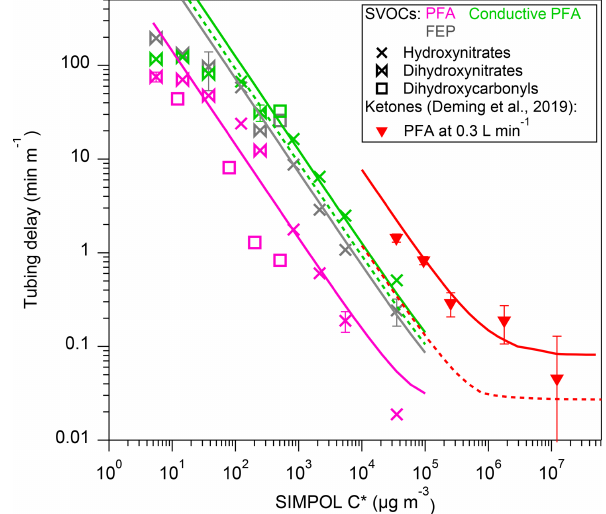
Figure 2. Measured instrument delay times as a function of SIM- POL C ∗ for five instruments. The q-PTRMS data are from Pago- Figure 3. Measured tubing delays normalized by tubing length as a nis et al. (2017) and the Vocus PTR-ToF data are from Krechmer function of the saturation concentration of the gas compounds. Also et al. (2018). Error bars are shown for some data points (the size shown as a comparison is the PFA result by Deming et al. (2019). would be similar for the rest of the points, not added to reduce figure Example error bars are shown, as propagated from exponential fits. clutter), calculated as standard deviations of two or three repeated Solid lines are chromatographic model results using the best esti- measurements. Also shown are approximate delays (shaded area) mated C w (for C ∗ = 10 2 –3 × 10 4 µgm − 3 ) for different tubing at observed with the NO − CIMS in Krechmer et al. (2016). 3 the same flow rates (Table 1). Dashed lines are model results for conductive PFA (this study) and PFA (Deming et al., 2019), using the C w determined in that work at 4Lmin − 1